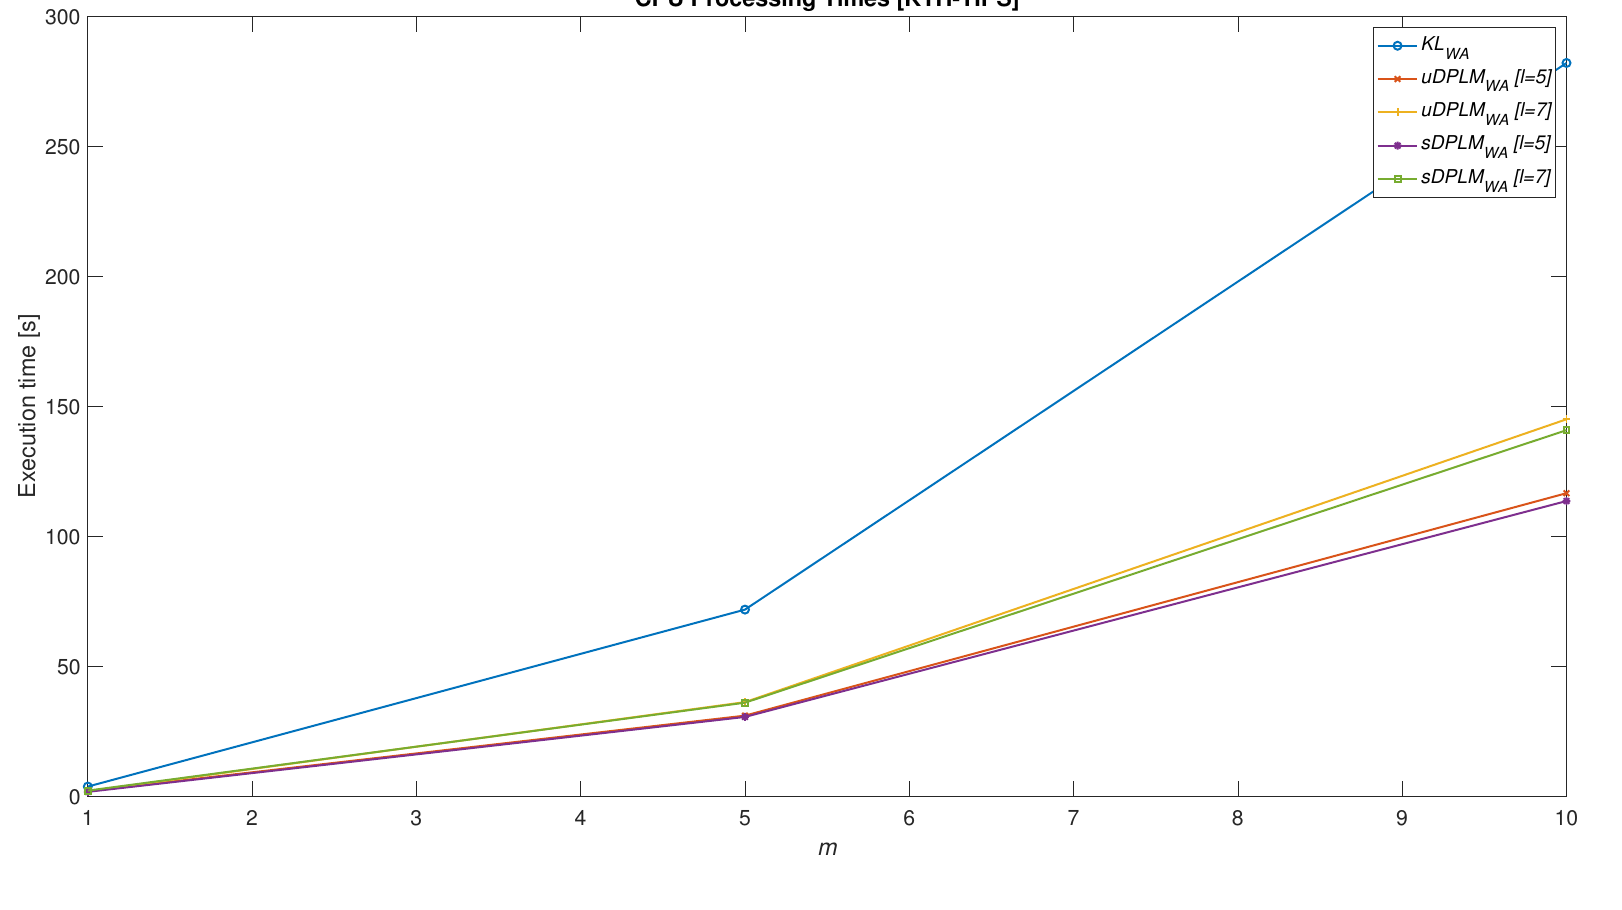
Figure 5. CPU processing times for the KTH-TIPS database, DPLM WA vs. KL WA